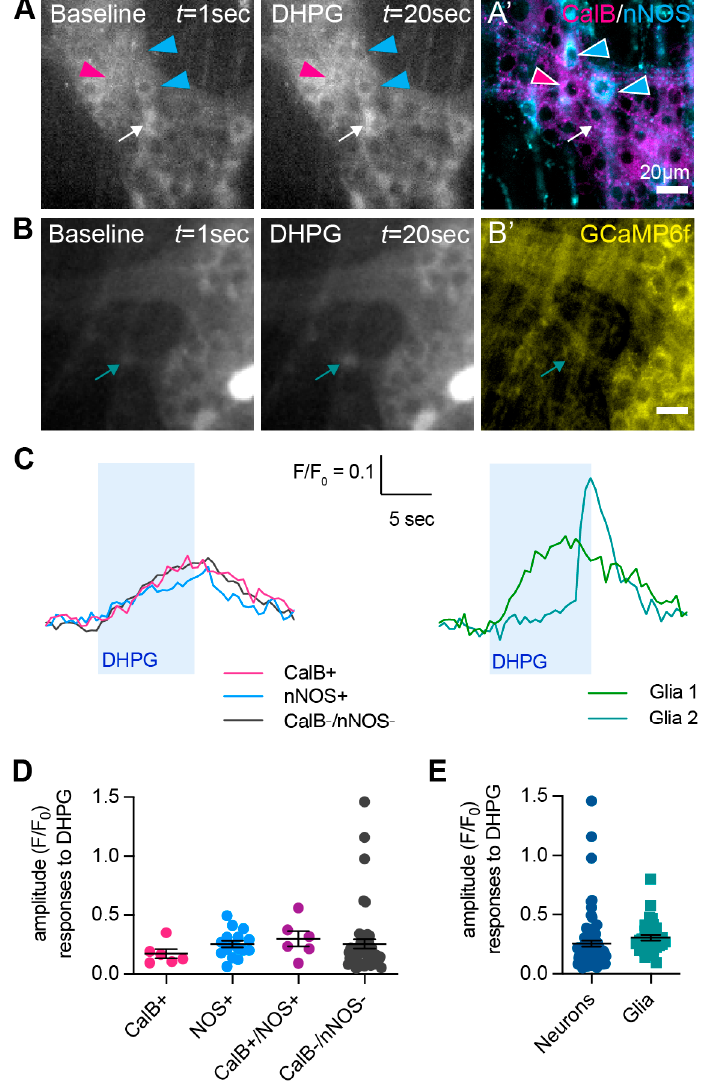
Figure 3. Responses to the application of the Group-I mGlu receptor agonist (RS)-3,5-DHPG. ( A , B ) Representative images of GCaMP6f fluorescence (grey) during live Ca 2+ recording of a myen- teric ganglion at baseline (left, t = 1 s) and after application of DHPG (right, t = 20 s). ( A ′ ) Post-hoc immunohistochemistry was performed on the same ganglion against calbindin (CalB+, magenta) and nNOS+ (cyan). Neurons responding to DHPG were subsequently identified to be CalB+ (ma- genta triangle), nNOS+ (cyan triangles), CalbB+/nNOS+ (not shown), or neither CalB+ nor nNOS+ (CalB − / − nNOS − ; white arrow). ( B ′ ) Post-hoc immunohistochemistry against GCaMP6f (yellow). Some DHPG-responsive cells had the morphology of enteric glia and, in some cases, were extra- ganglionic (green arrow). ( C ) Representative traces from a CalB+ neuron (magenta), nNOS+ neuron (blue), and CalB-/nNOS-, responding to the application of DHPG (left). Representative traces from two presumptive glial cells responding to the application of DHPG (right). ( D ) Quantification of [Ca 2+ ] i transient amplitudes to DHPG in CalB+ neurons ( Δ F/F 0 0.17 ± 0.04, n = 6), nNOS+ neurons ( Δ F/F 0 0.25 ± 0.03, n = 16), CalB+/nNOS+ neurons ( Δ F/F 0 0.30 ± 0.07, n = 6), and CalB − /nNOS − neurons ( Δ F/F 0 0.26 ± 0.04, n = 49). ( E ) Quantification of [Ca 2+ ] i amplitudes to DHPG in neurons overall ( Δ F/F 0 0.26 ± 0.03, n = 80) vs. presumptive glial cells ( Δ F/F 0 0.31 ± 0.02, n = 34). Scalebars = 20 µm.